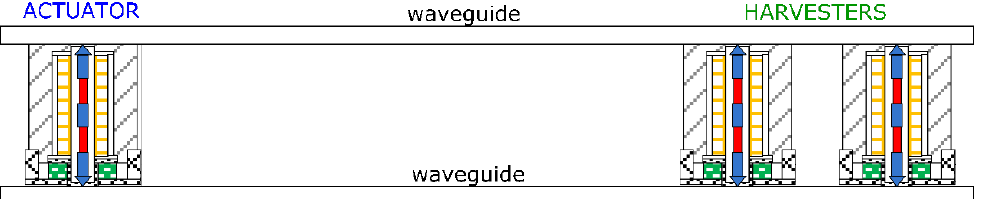
Figure 8. A block diagram of SURPS structure. The main applications of SURPS encompass: •